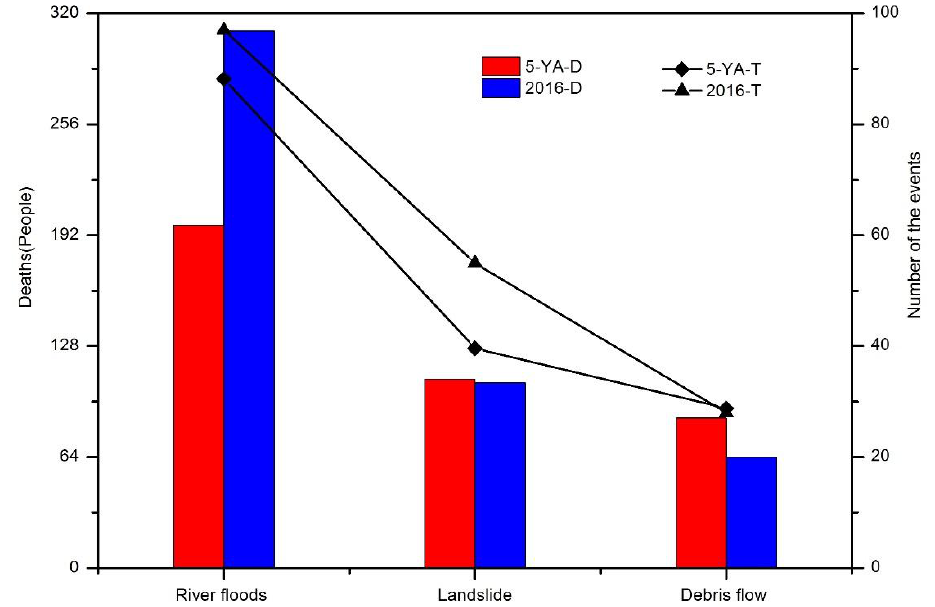
Figure 6. Fatality of different types of natural disasters in 2011–2016. (5-YA-D: the number of deaths from 2011 to 2015, 5-YA-T: the number of flash flood events from 2011 to 2015; 2016-D: the number of deaths in 2016, 2016-T: the average number of flash flood events in 2016).